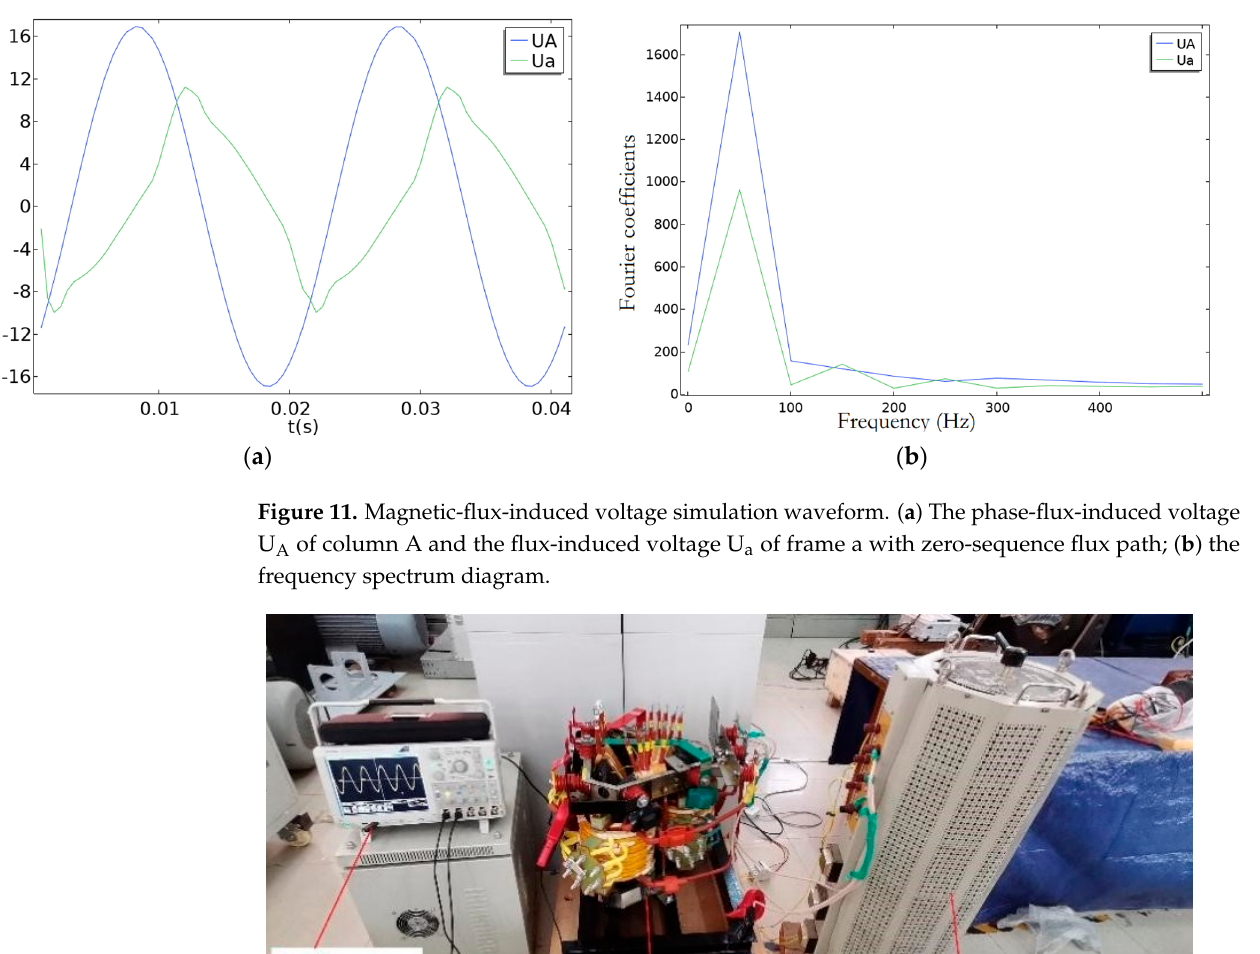
Figure 10. Magnetic density distribution under different voltage excitation ( a ) 0.9 times voltage excitation ; ( b ) 1 times voltage excitation ; ( c ) 1.05 times voltage excitation .